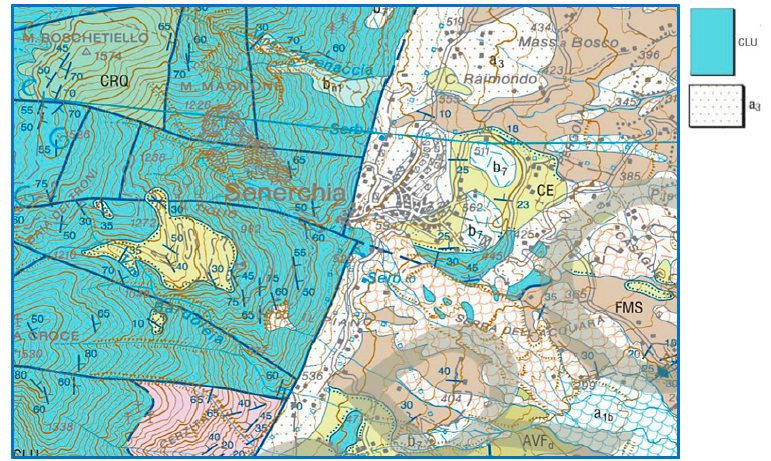
Figure 9. The geology of the study